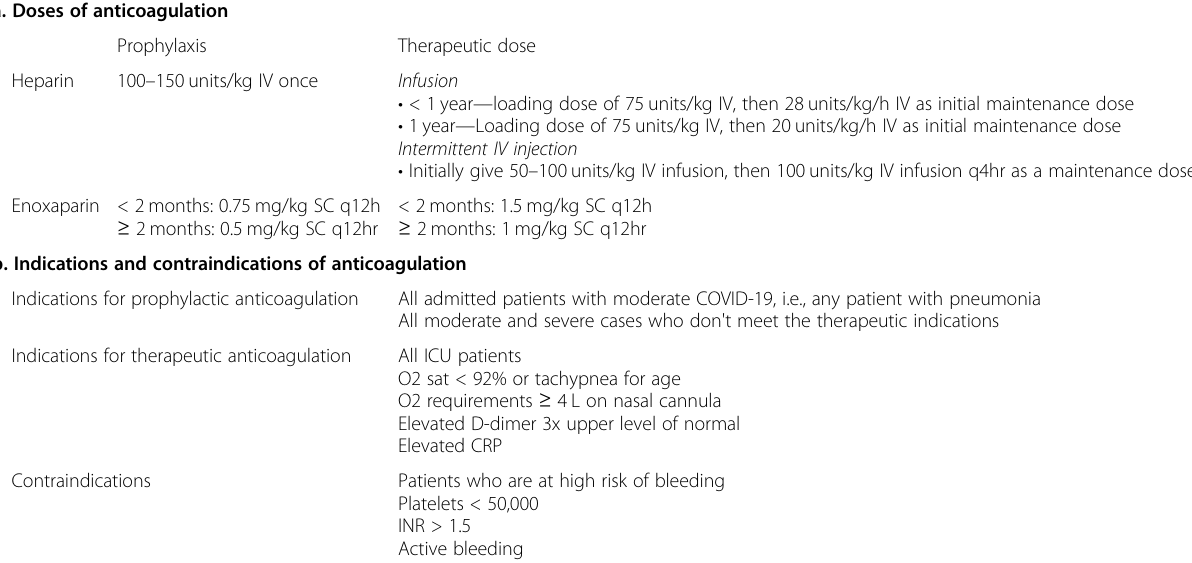
Table 3 Pediatric COVID-19 anticoagulation regimens